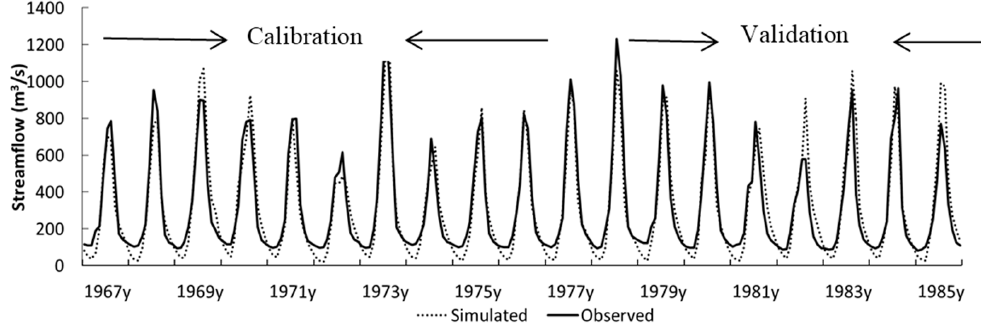
Figure 6. Observed and simulated stream flows at Garm gauging station in the calibration (1967–1978) and validation (1979–1985) periods.